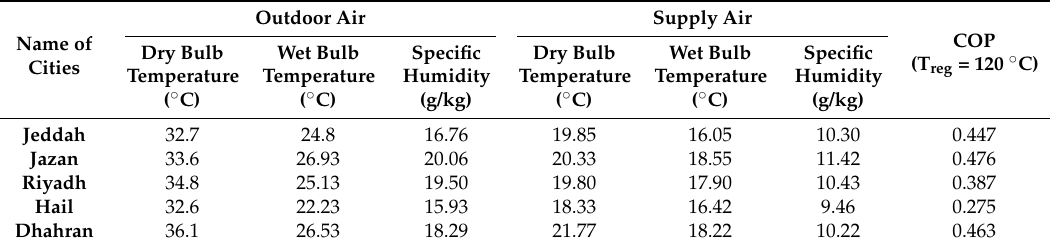
Table 4. Average outdoor conditions, supply conditions, and coefficient of performance of a desiccant cooling cycle for different cities of Kingdom Saudi Arabia